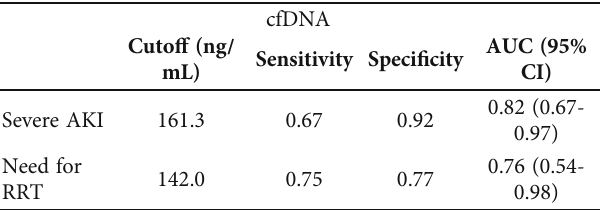
Table 2: Diagnostic performance of cell-free DNA (cfDNA) for predicting severe